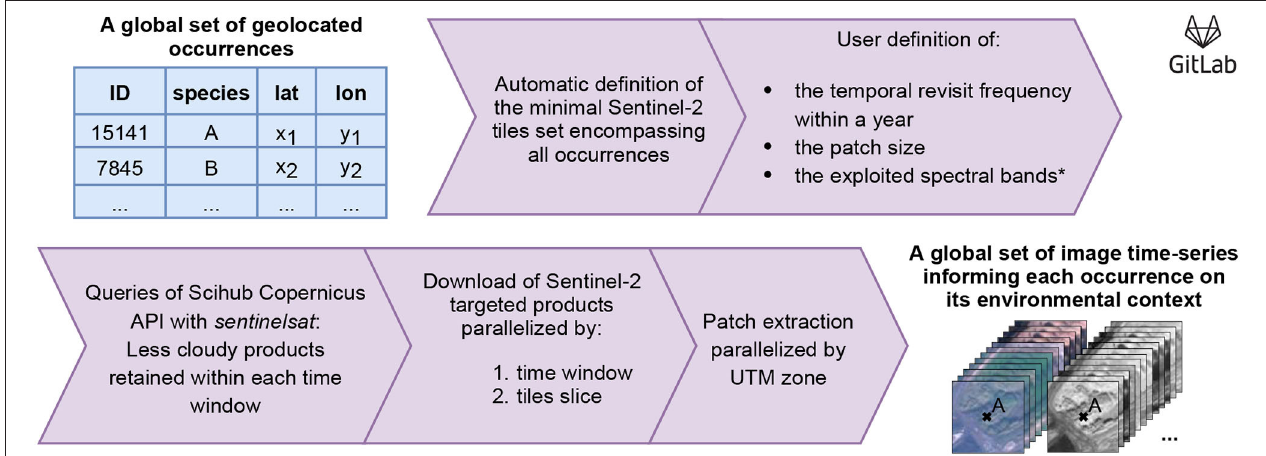
FIGURE 3 | Creation workflow of DeepOrchidSeries dataset. Input is a set of geolocated occurrences, output gathers image time series informing on species habitat preferences. Code and details are available at